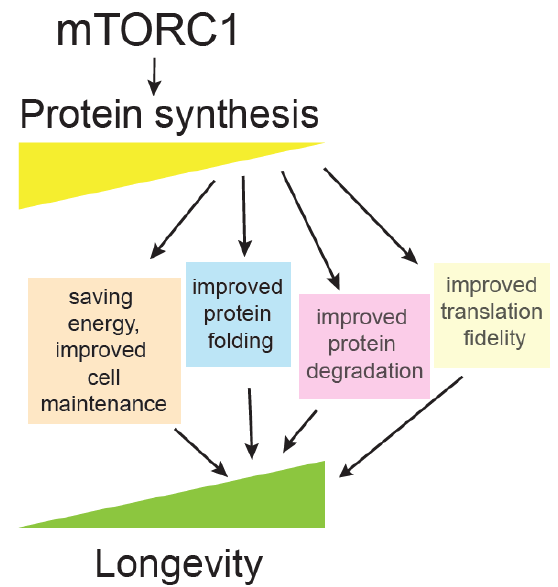
Figure 3. mTORC1 promotes protein synthesis. Decreased protein synthesis correlates with extension of lifespan and many mutants affected in translation initiation, elongation, and ribosomal proteins are long-lived. Some of the proposed mechanisms whereby less translation could promote longevity are illustrated.